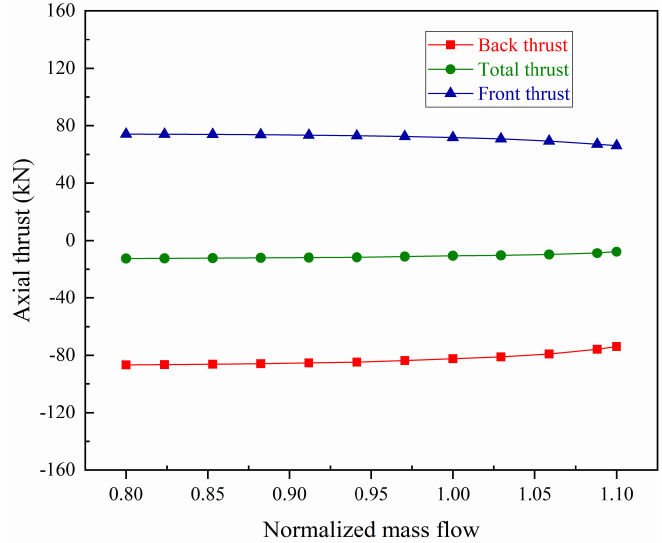
Figure 7. Predicted axial thrust under design rotating